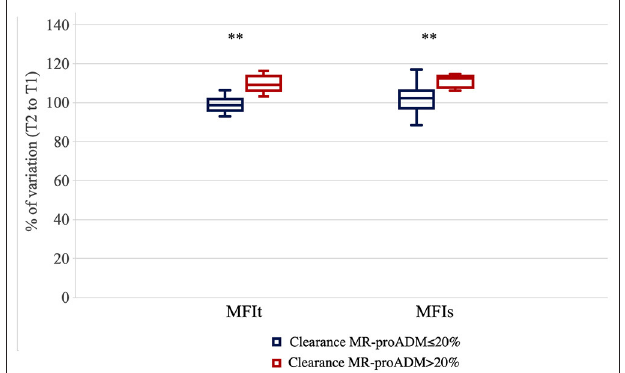
FIGURE 1 | Percentage of variation for microvascular flow index of total vessels (MFIt) and MFI of small vessels (MFIs) in the first 24h of evaluation in the two groups of patients [clearance of mid-regional proadrenomedullin (MR-proADM) inferior-to-equal or higher than 20%]. ** p < 0.01.